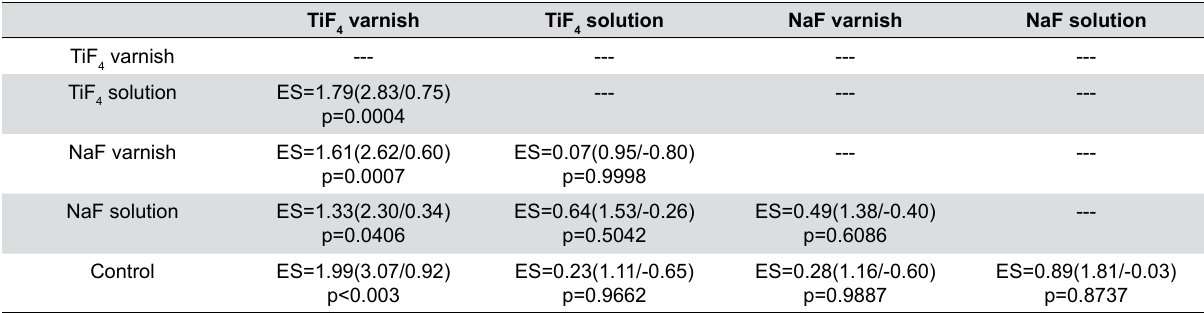
Table 2- Results of pairwise comparisons of shear bond strength test: Cohen’s d effect size (ES) and its 95% confidence interval (upper limit of confidence interval/lower limit of confidence interval), and p-value